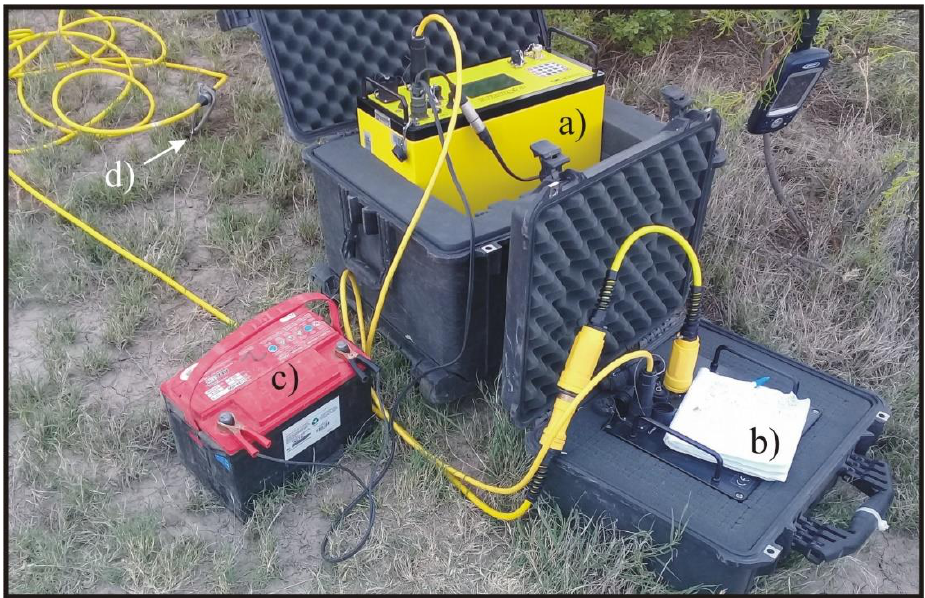
Figure 2. Data collection using the AGI SuperSting R1/IP/SP. ( a ) SuperSting TM console, ( b ) Switch box, ( c ) Battery, ( d ) Electrode.